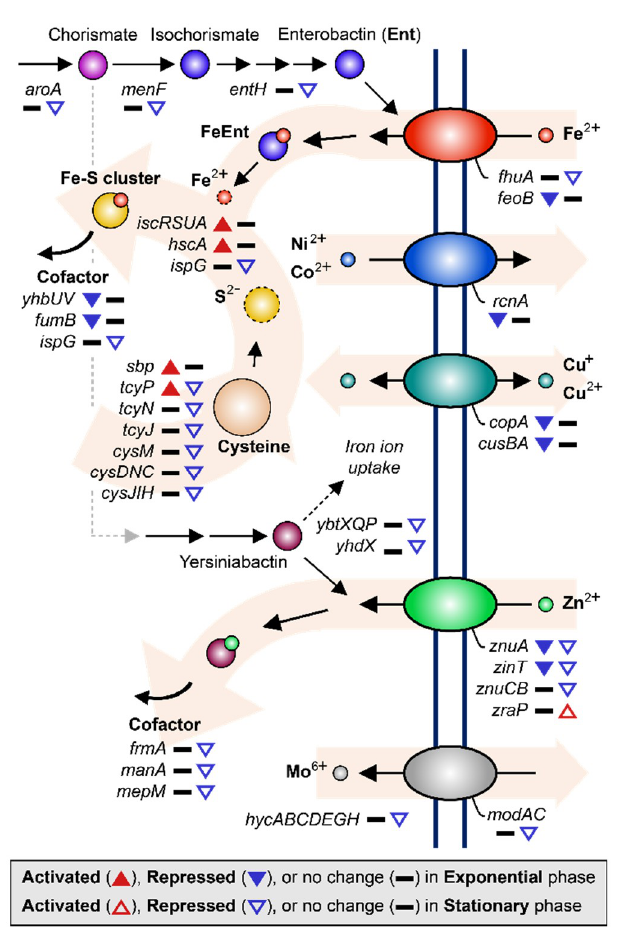
Figure 4. DEGs related to metal ion acquisition and utilization are shown. The up-regulated and down-regulated genes under the MG condition compared to the NG condition are depicted by the direction of the up and down arrowheads, respectively. DEGs during the exponential and stationary growth phases are indicated by the solid and empty arrowheads, respectively.